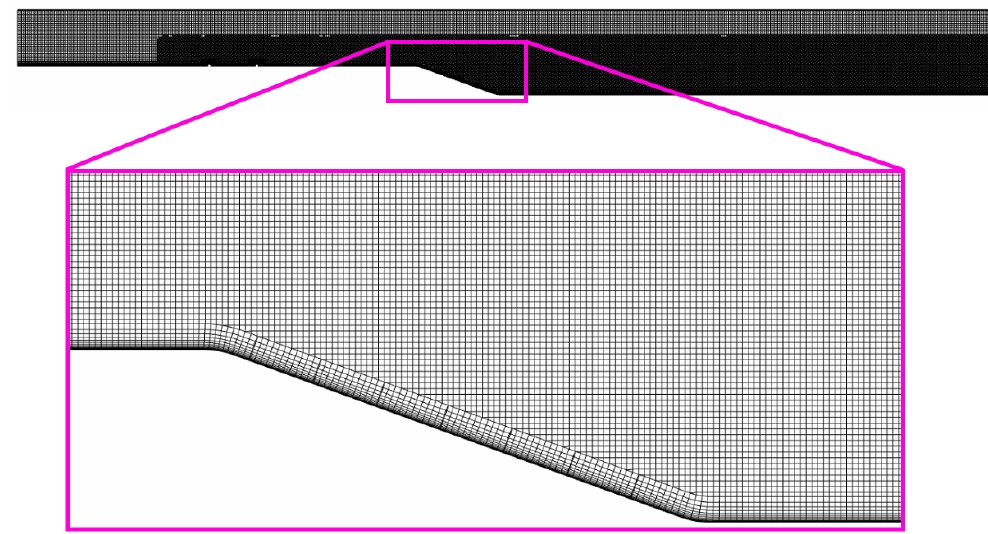
Figure 4. Computational grid surrounding the ramp on plane R.